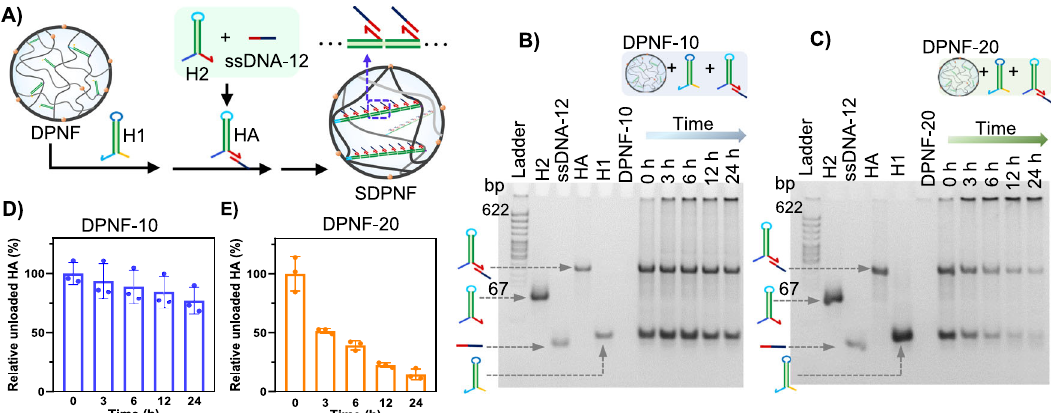
Fig. 3 Programmable assembly of ssDNA-12 in DPNF via HCR of DNA hairpins. A Schematic description of assembling ssDNA-12 in DPNFs: the ssDNA- 12 was linked with H2 to form HA fi rst, and then H1 (3 μ M) and HA (3 μ M) was co-incubated with DPNFs (0.42 mg/ml). B Gel electrophoresis analysis of loading of H1 (3 μ M) and HA (3 μ M) in DPNF-10 or DPNF-20 (0.42 mg/ml) versus incubation time according to the strategy represented in ( A ). D , E are quantitative analysis of unloaded HA versus incubation time in ( B ) and ( C ), respectively, using image J software. Error bars represent s.d. ( n